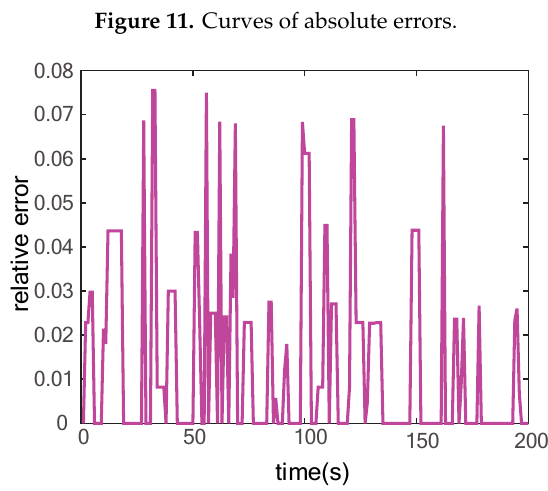
Figure 12. Curve of relative errors.